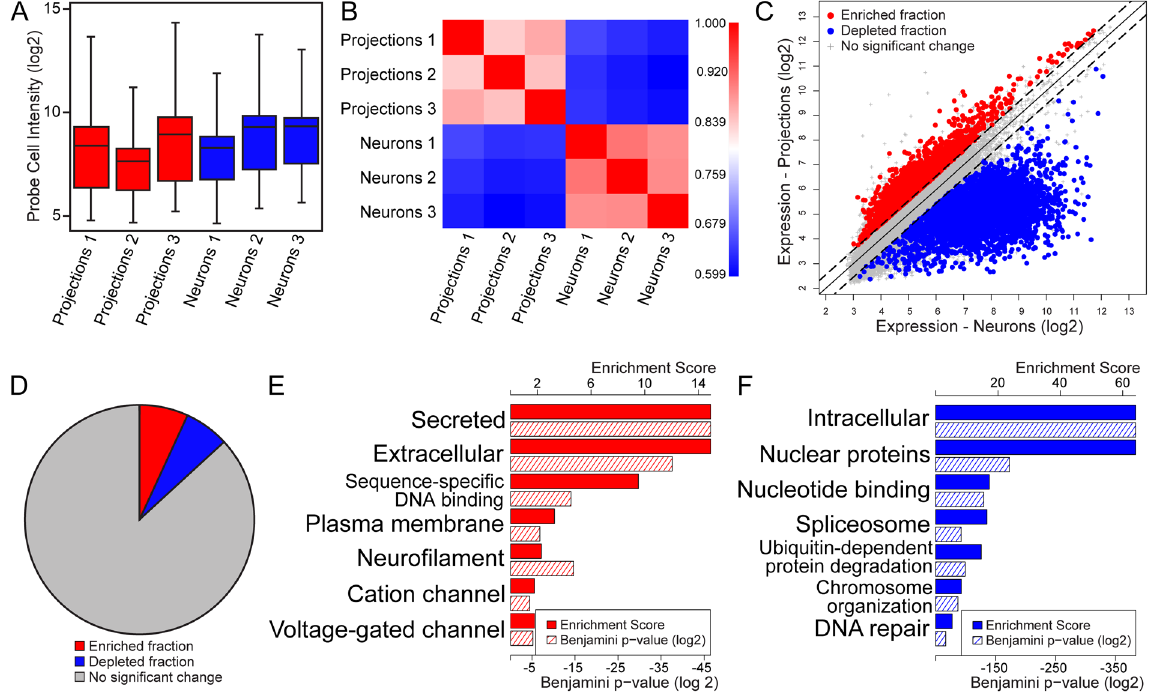
Figure 2. Differential gene expression between the transcriptome of distal projections and the neuronal transcriptome of hESC-neurons. mRNAs from hESC-neurons grown in axon isolating microfluidic chambers were evaluated using Affymetrix microarrays. ( A ) Box and whiskers plot of the raw probe cell intensity values (log2) of Affymetrix microarrays of samples from the axonal and somatic compartments (‘projection’ and ‘neuron’ samples, respectively) in triplicate. ( B ) Pearson correlation coefficient of microarray data from axonal and neuronal samples. ( C ) Gene expression scatterplot comparing expression levels in hESC-neurons and distal projections. Threshold for proportional enrichment or depletion was set at ± 1.5 fold change, ANOVA p-value < 0.05. The proportionally enriched fraction is shown in red, 3942 probe sets. The proportionally depleted fraction is shown in blue, 3630 probe sets. ( D ) Pie chart depicting the percentages of the total microarray probe sets that reached threshold to be considered enriched (8.17% of probe sets, red region) and depleted (7.53% of probe sets, blue region) within the axonal compartment. ( E ) Gene ontology (GO) enrichment scores (solid red bars, scale along the top) and Benjamini p-values (hashed red bars, scale along the bottom) of the proportionally enriched fraction as determined by DAVID Gene Functional Classification. ( F ) GO enrichment scores (solid blue bars, scale along the top) and Benjamini p-values (hashed blue bars, scale along the bottom) of the proportionally depleted fraction as determined by DAVID Gene Functional